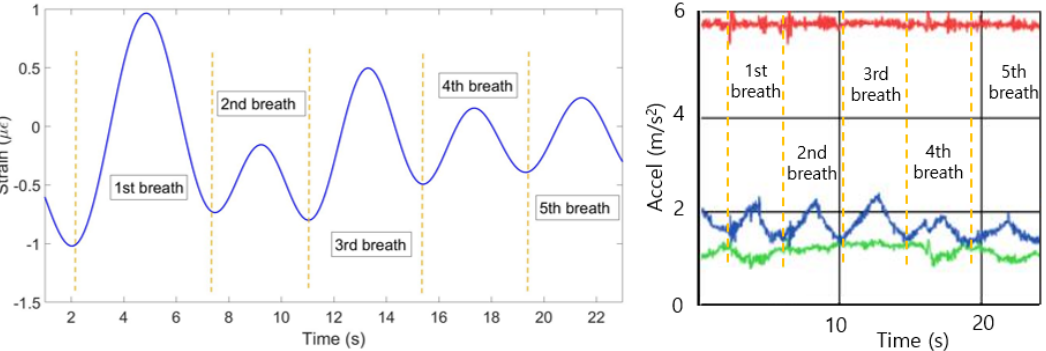
Figure 12. Breathing pattern for the second volunteer in the staying position detected by: FBGs on the chest ( left ) and abdomen regions ( right ).